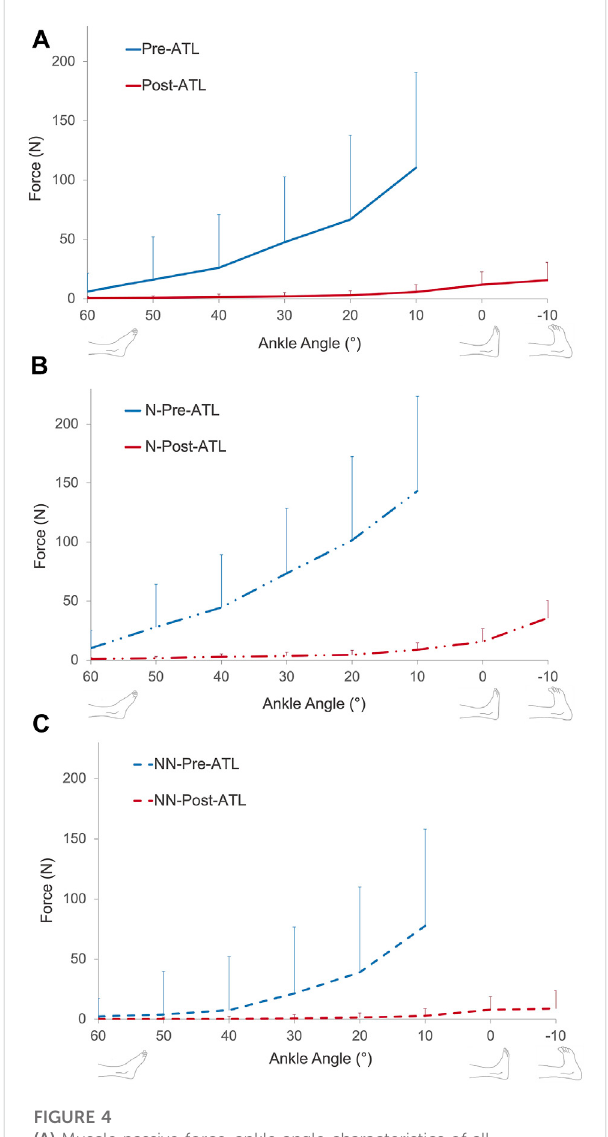
FIGURE 4 (A) Muscle passive force-ankle angle characteristics of all patients pre- and post-ATL. Muscle passive force-ankle angle characteristics of patients with (B) and without (C) neurological conditionspre-andpost-ATL.N=neurologicpatient,NN=non- neurological